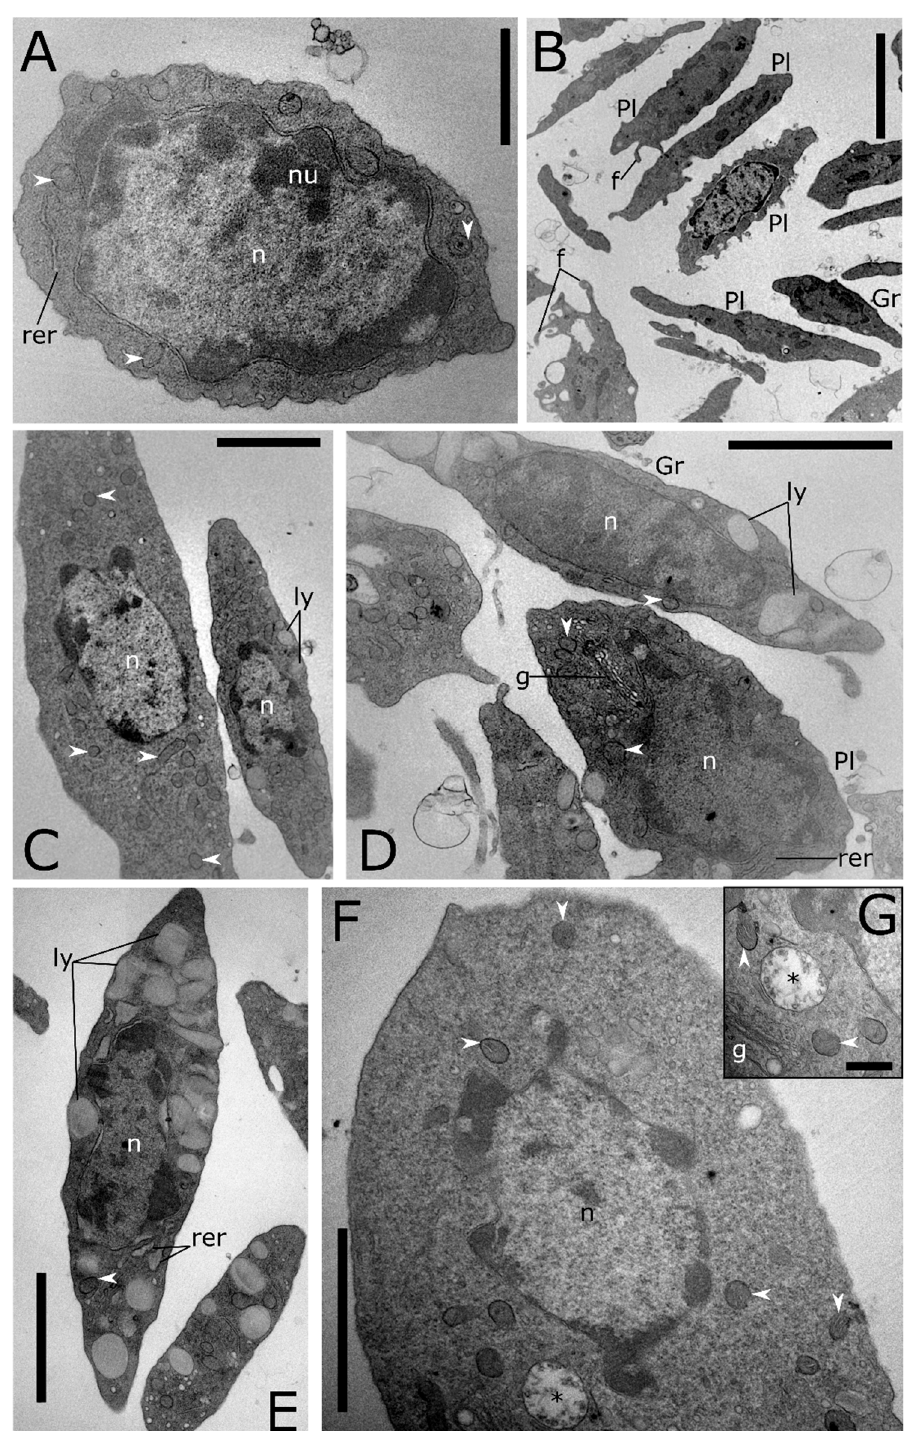
Figure 2. Transmission electron micrographs of haemocyte cross sections from T. molitor . ( A ) Prohaemocyte. ( B ) Plasmatocytes (Pl) and a granular cell (Gr). ( C ) Longitudinal section of plasmatocytes. ( D ) Granular cells (Gr) with electron-dense granules (ly) in the cytoplasm and plasmatocytes (Pl) with an evident Golgi apparatus (g). ( E ) Granular cell with granules (ly) storing homogenous electron-dense material. ( F ) Oenocytoid. ( G ) Detail of the oenocytoid showing multivesicular body (asterisk) and Golgi complex (g); n: nucleus, nu: nucleolus, rer: rough endoplasmic reticulum, white arrowheads: mitochondria. Bars: 5 μ m ( B ); 2 μ m ( C – F ); 1 μ m ( A ); 500 nm ( G ).